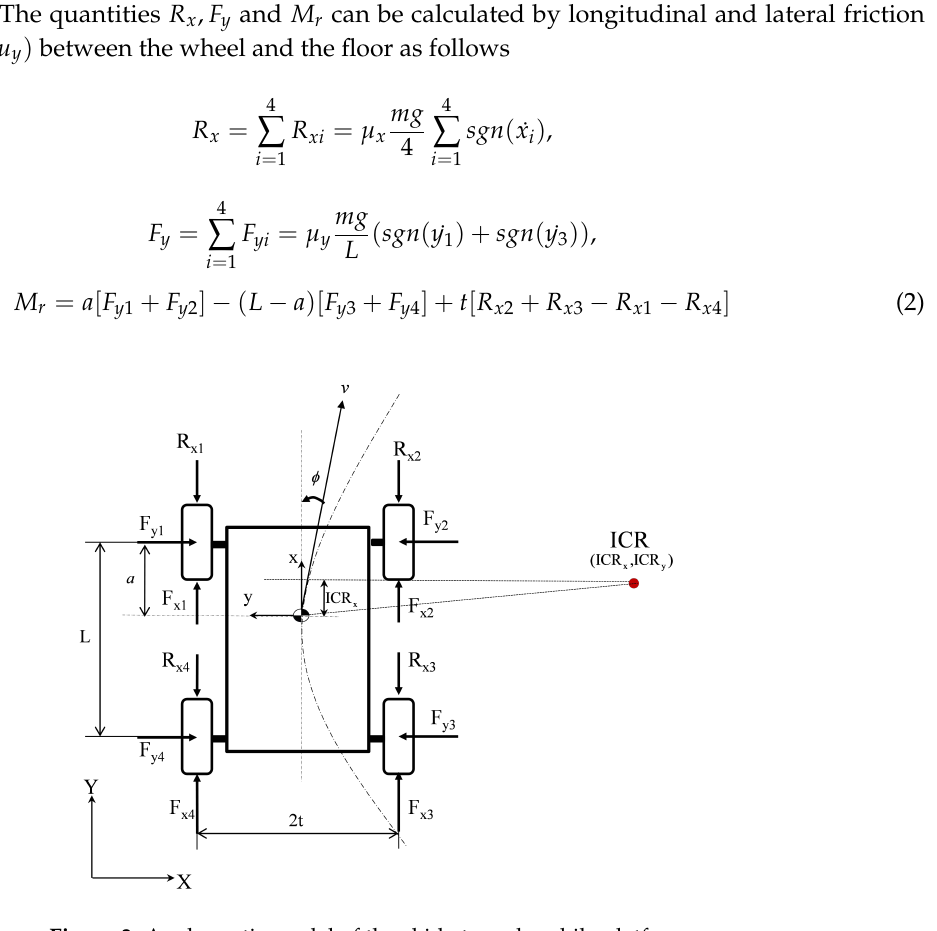
Figure 3. A schematic model of the skid-steered mobile